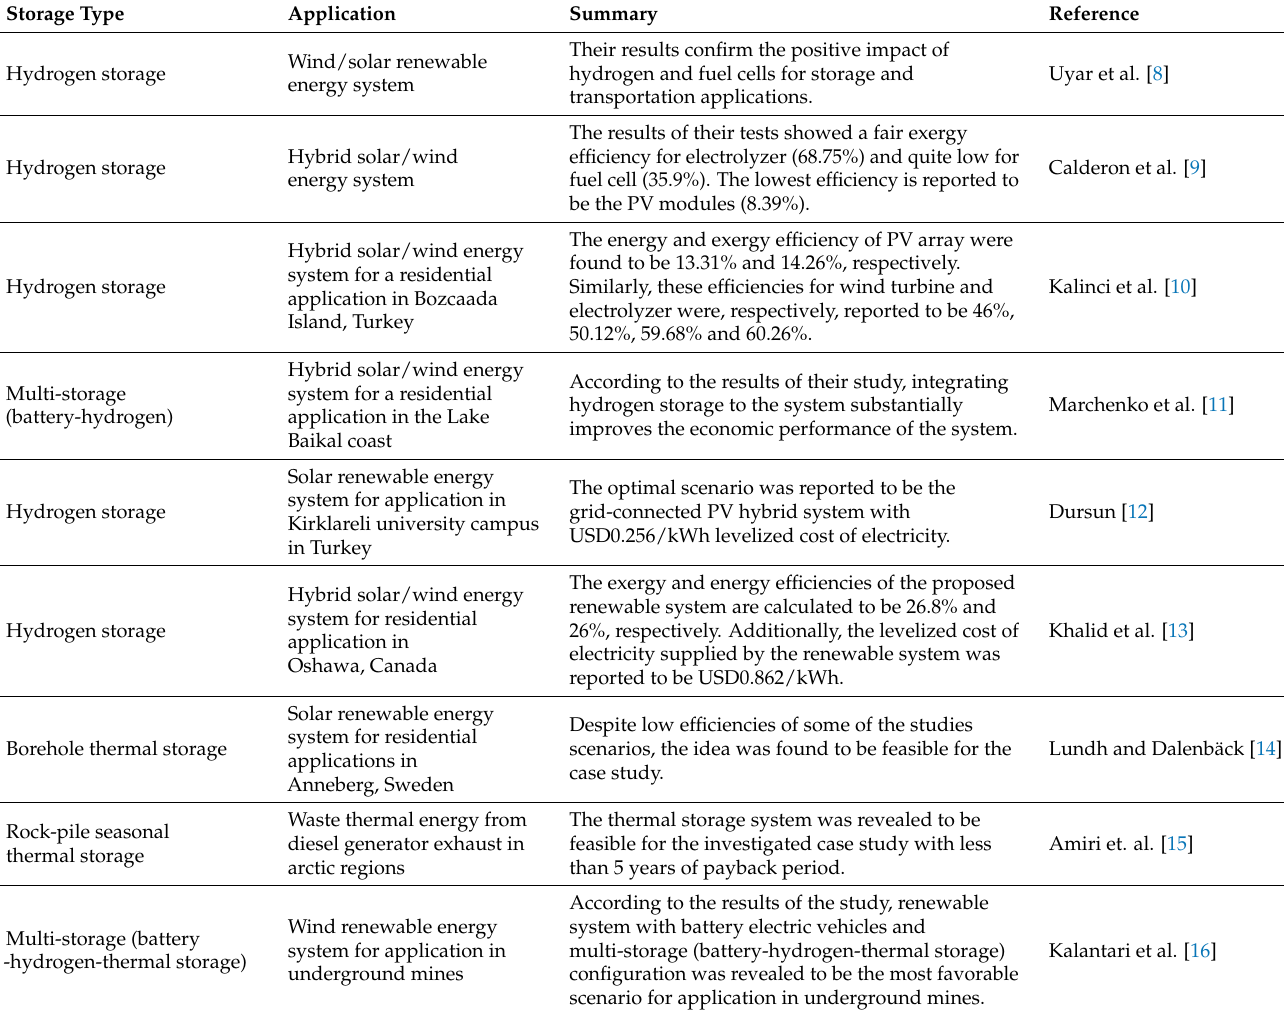
Table 1. Studies of storage systems for application in smaller-scale decarbonized energy